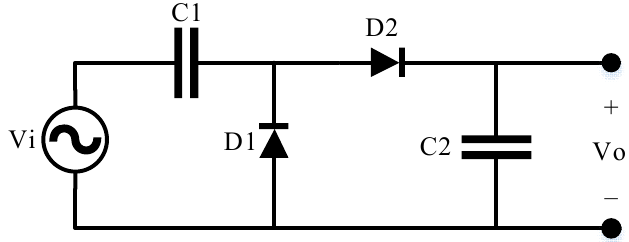
Figure 1. Greinacher voltage doubler .